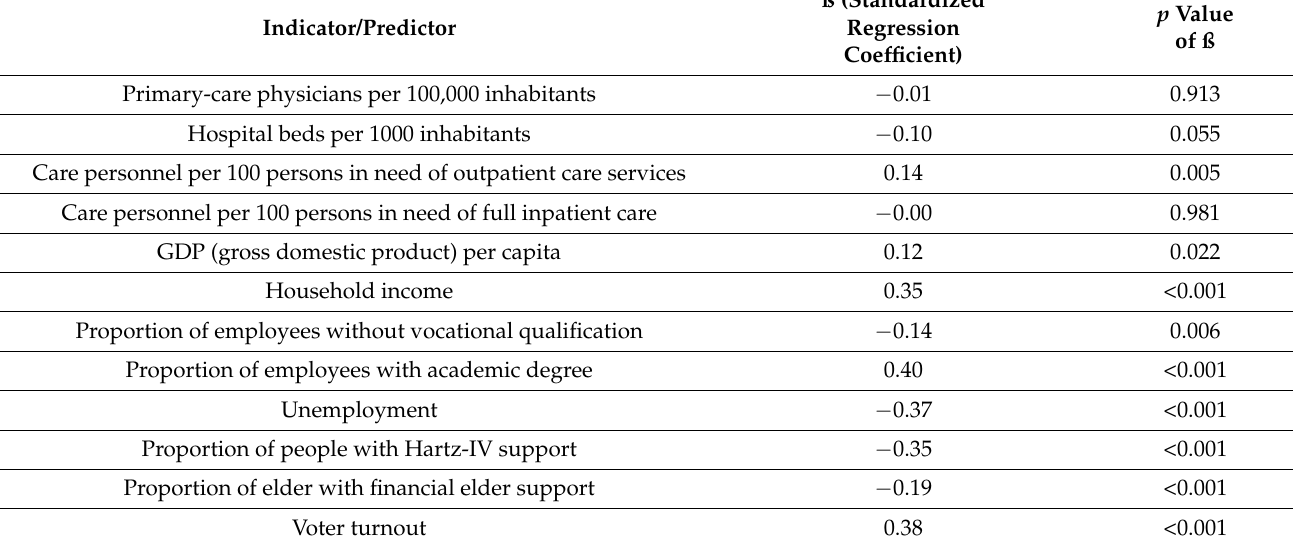
Table 3. Results of bivariate regression analyses of women’s remaining life expectancy at age 60 at district level (dependent variable) with 12 potential predictors: ß (standardized regression coefficient) and p value of ß; N = 401 German